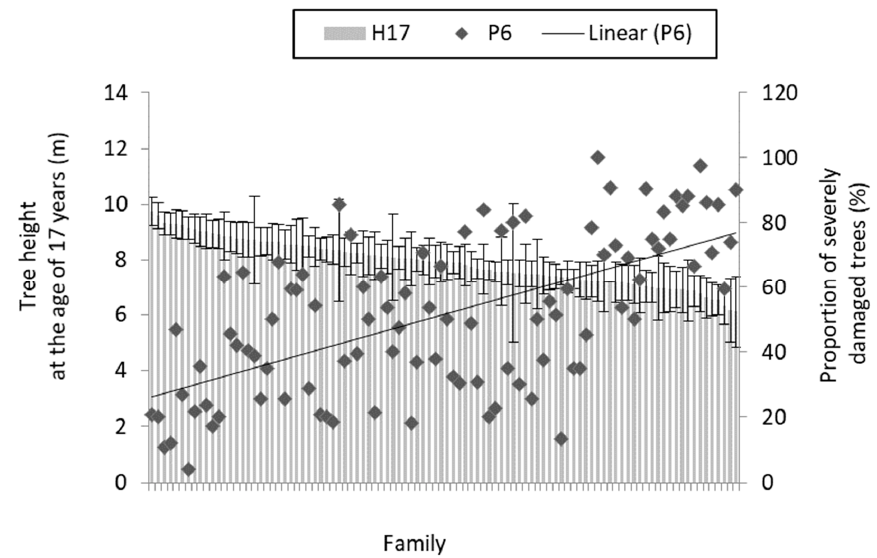
Figure 3. The relation between tree height at the age of 17 years (H17) and proportion of severely damaged (pooled grades 4 and 5) trees in the sixth growing season (P6) at the family mean level (families ordered descending according to mean height). Whiskers denote 95% confidence intervals.